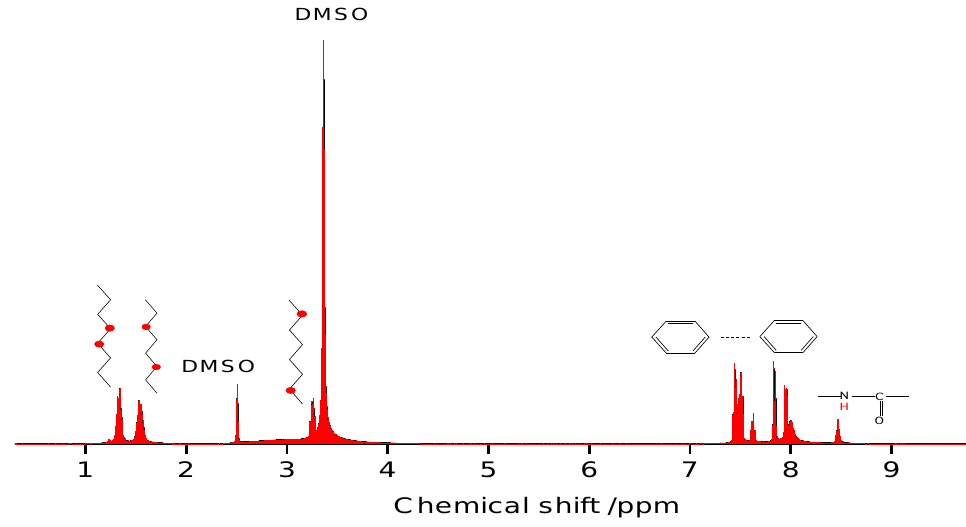
Figure 3. The 1 H NMR analysis of HMDA derivatives in 90 wt% DMSO solution.